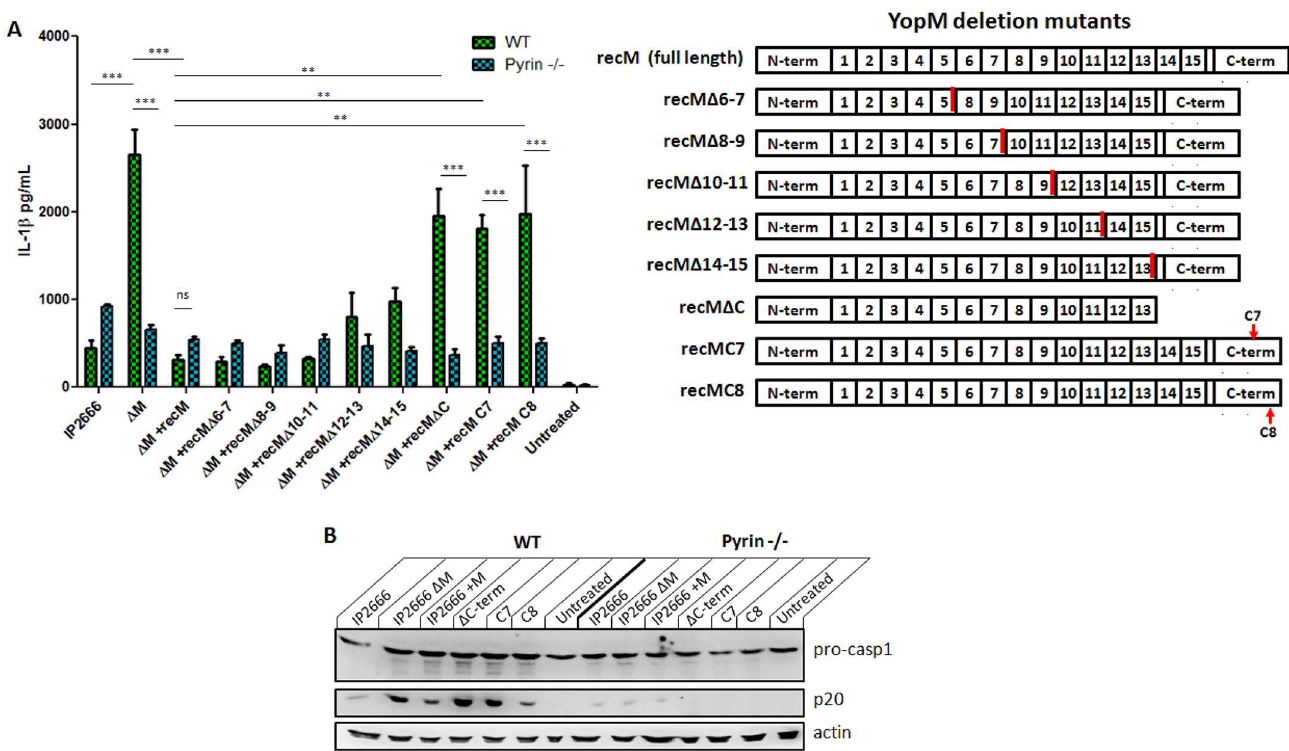
Fig 4. A) IL-1 β was measured by ELISA in supernatantsof LPS-primed BMDMs infected for 6 hours with Y . pseudotuberculosis IP2666, including strains expressingYopM with partial deletions(MOI 10). The numbersin the YopM protein refer to different leucine-richrepeat (LRR) domainsof YopM, and C-term indicatesthe C-terminal end. RecM indicatesreconstitution (rec) of IP2666 Δ YopMwith variants of YopM, as shown in the figure. C7 and C8 are two different triple alaninesubstitutionsnear the C-terminus of YopM [33]. B) Total protein from LPS-primed BMDMs infected with indicatedstrains (combined cell lysate and supernatant) was separatedby SDS-PAGE and analyzedby Western Blot for IL-1 β and caspase-1.Figures are representative of two independentexperiments. Shownis mean plus s.d. for triplicate wells. * p < 0.05, ** p < 0.01, *** p <